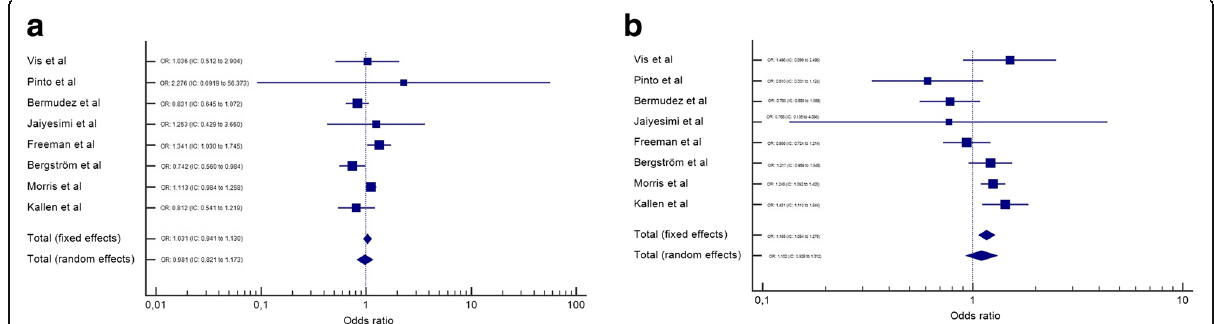
Fig. 3 Meta-analysis of ASD and VSD by gender in Down syndrome. IC-Interval of confidence. OR-Odds Ratio. a – OR meta-analysis of ASD in Down syndrome by gender. b – OR meta-analysis of VSD in Down syndrome by gender